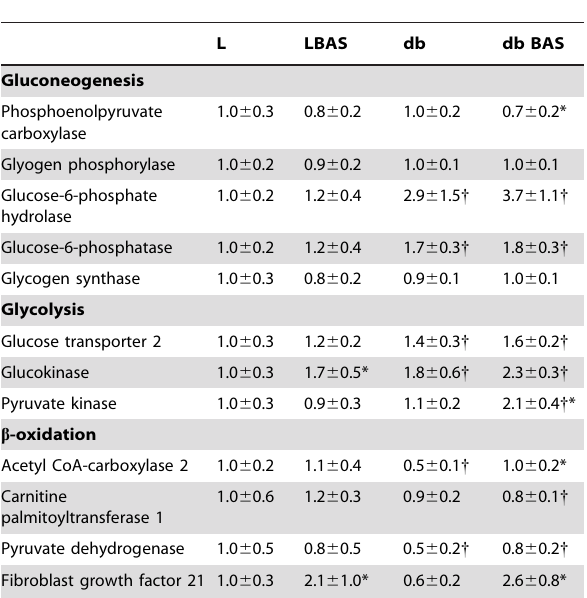
Table 3. mRNA expression levels.